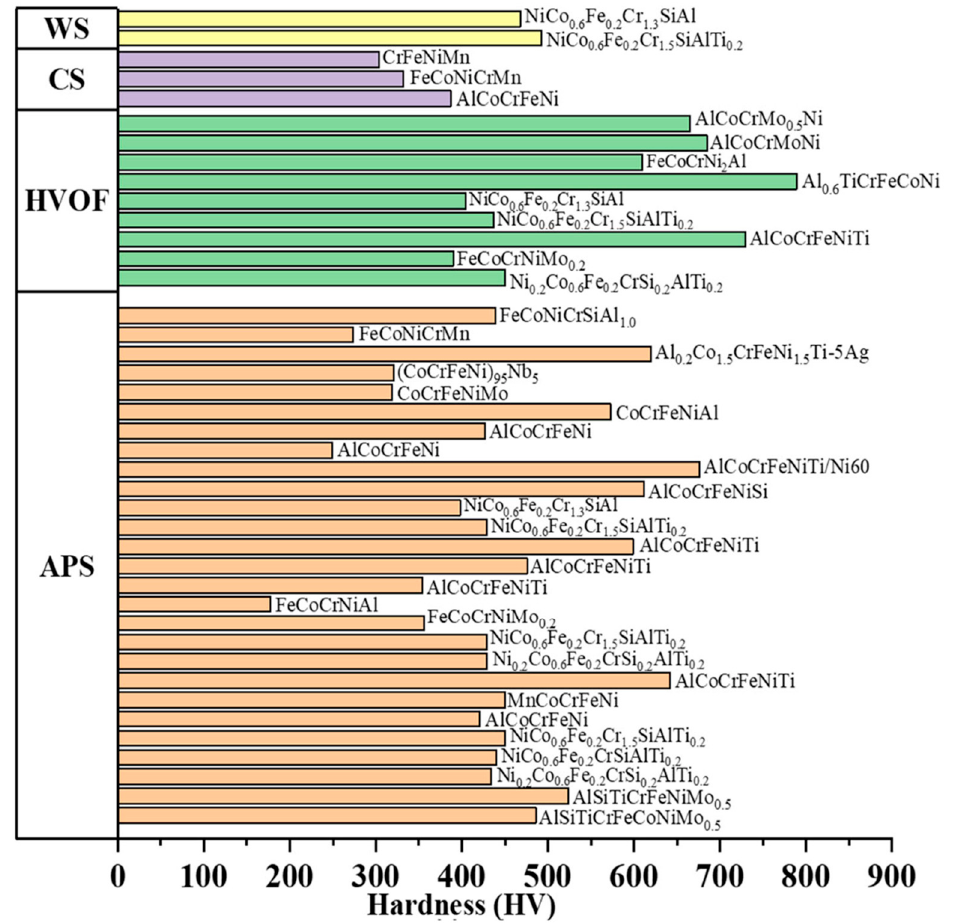
Figure 15. Variation of hardness of various CCA-based coatings through various thermal spray approaches [28].